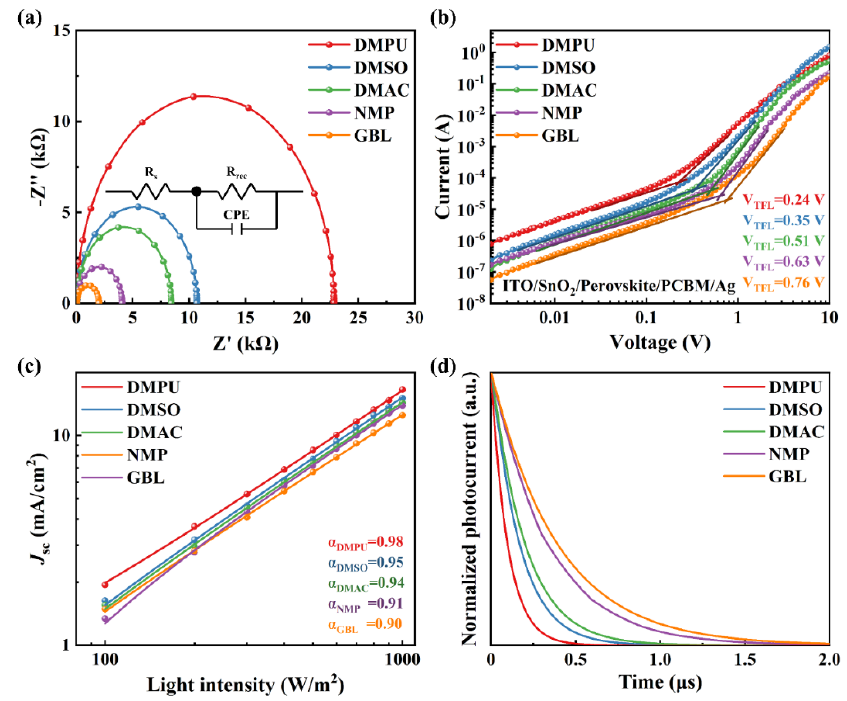
Figure 3. ( a ) EIS measurements of devices prepared with different assistant solvents. ( b ) Dark J-V characteristics of electron-only devices. ( c ) IMPS and ( d ) normalized TPC curves of devices prepared with different solvents.